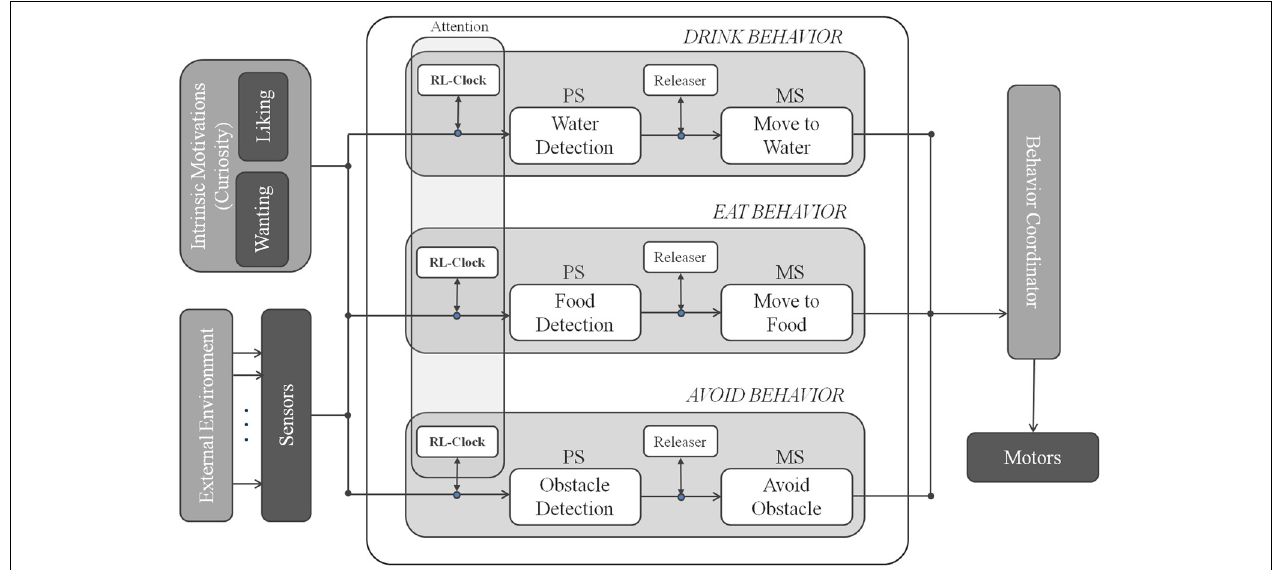
FIGURE 4 | Attentional behavior-based architecture with intrinsic motivations.